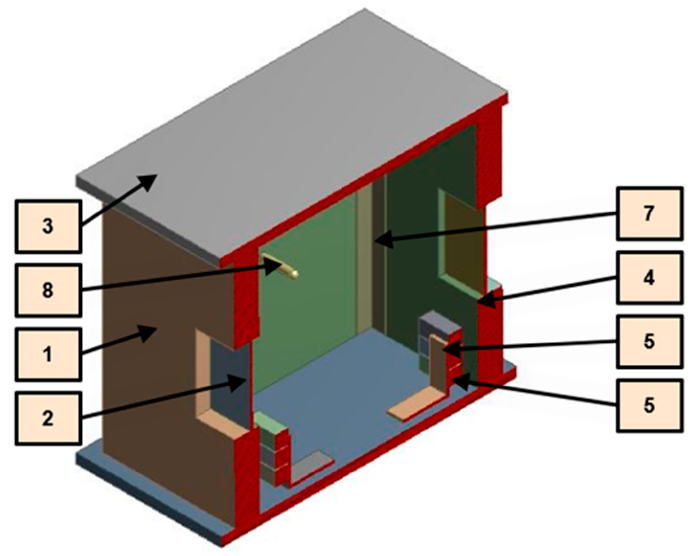
Figure 7. Description of the laboratory scale test platform.